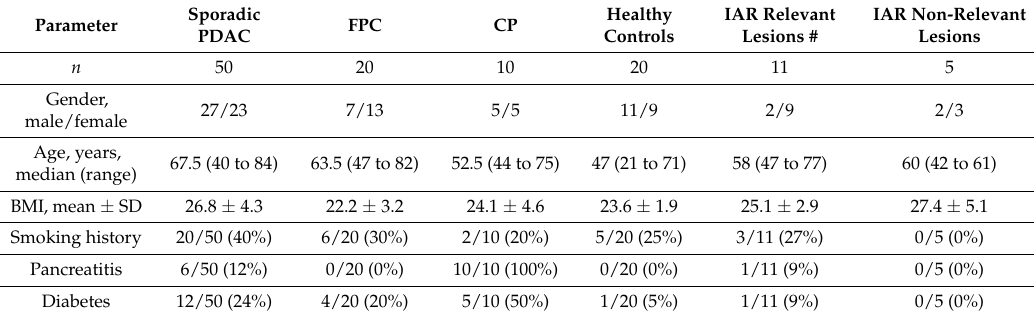
Table 1. Patients’ characteristics.